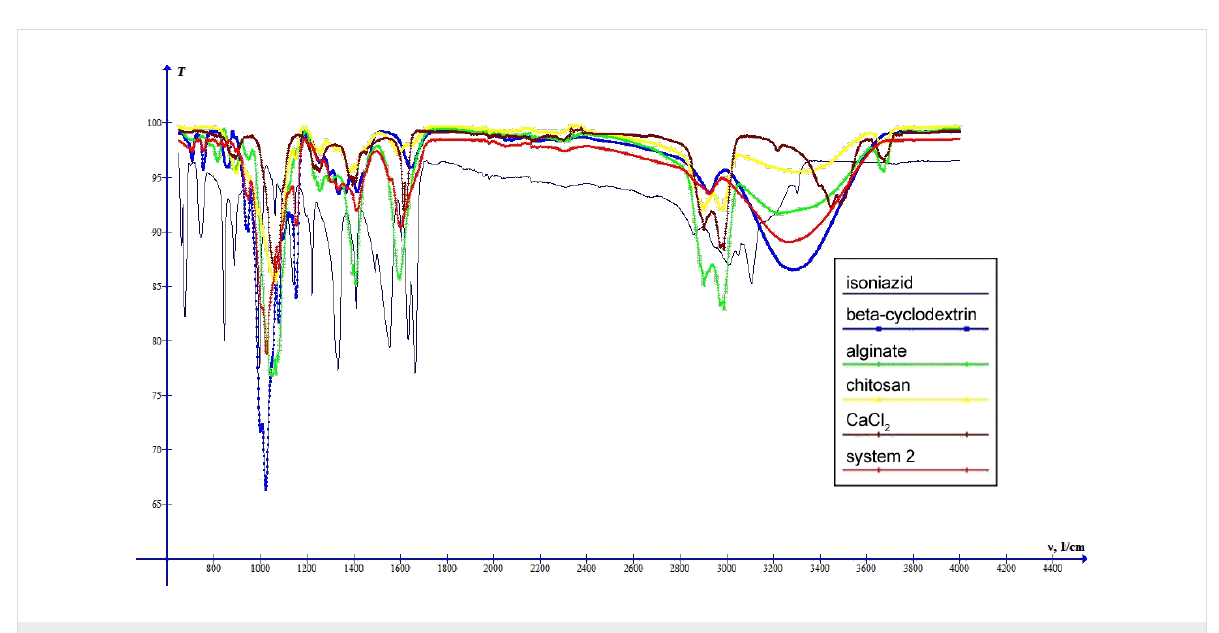
Figure 8: IR spectra of INH, β -cyclodextrin, sodium alginate, chitosan, calcium chloride and system